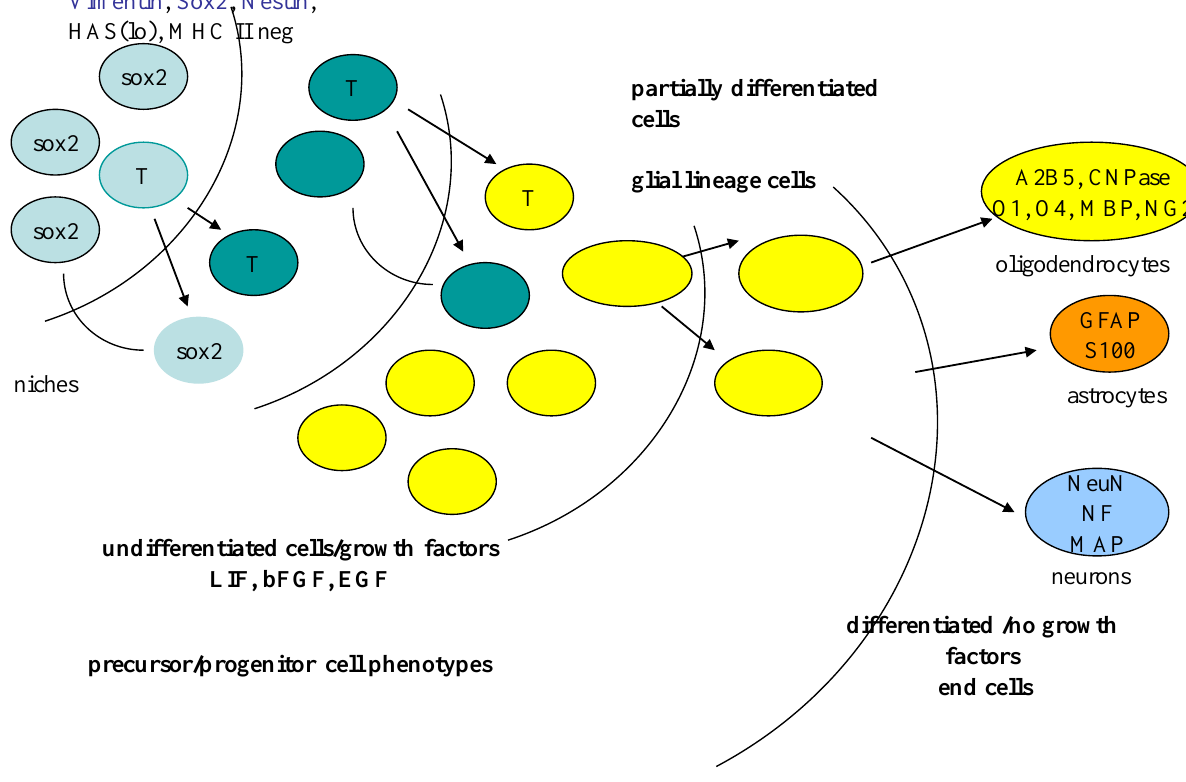
Figure 1. Replacement cells are provided through a hierarchy of cell types that result when self-renewing stem cells proliferate through asymmetrical and/or symmetrical division to form precursor and progenitor cells. Upon differentiation, neurons are